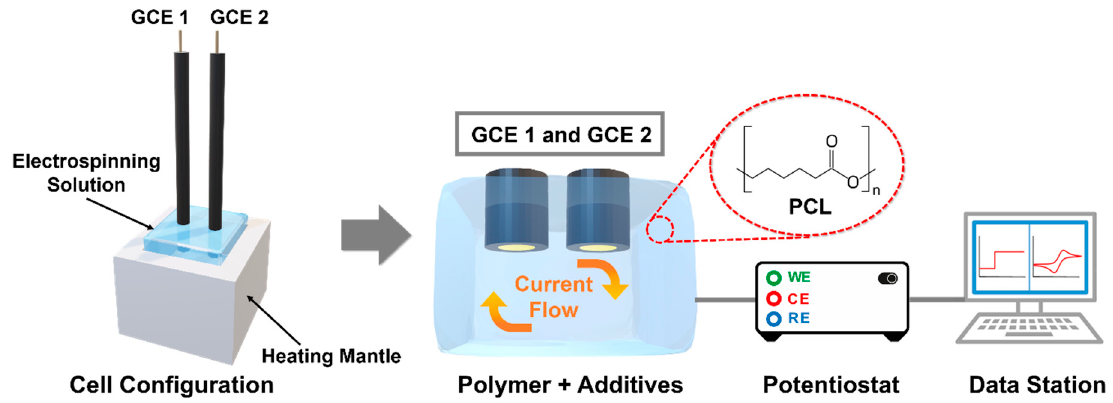
Figure 1. Schematic of equipment used for conductivity measurement.